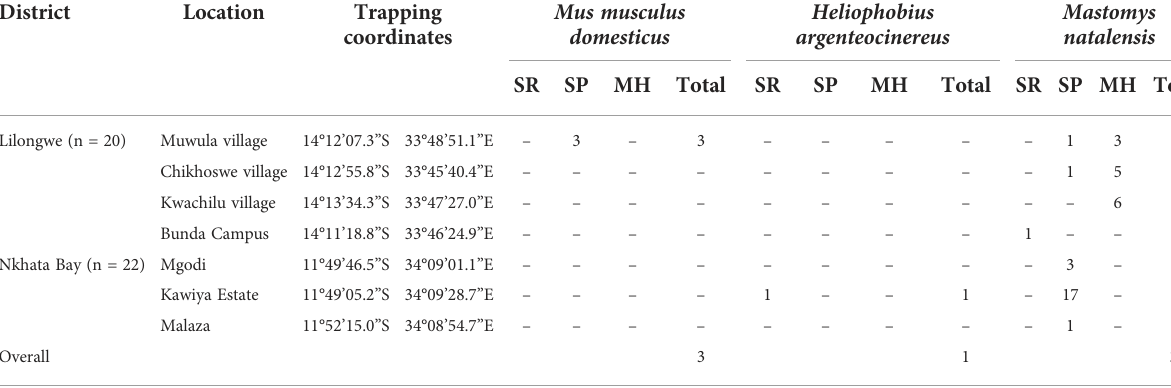
TABLE 5 Rodent trapping per location and species. SR, Sherman trap; SP, Snap trap; MH, Mouse hunter.